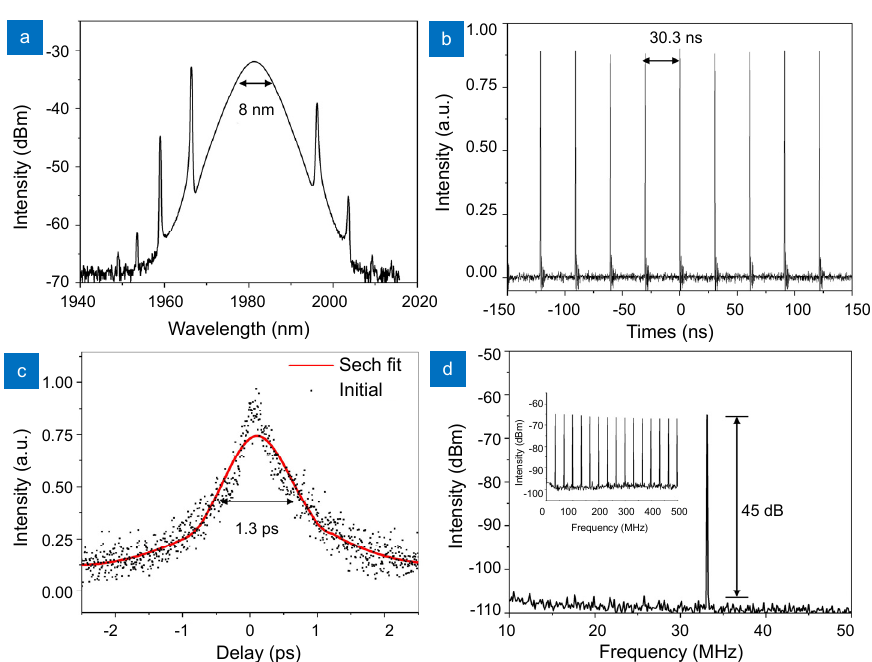
Fig. 2 | Conventional soliton at -0.508 ps 2 net dispersion. ( a ) Optical spectrum. ( b ) Pulse train. ( c ) Autocorrelation trace. ( d ) RF